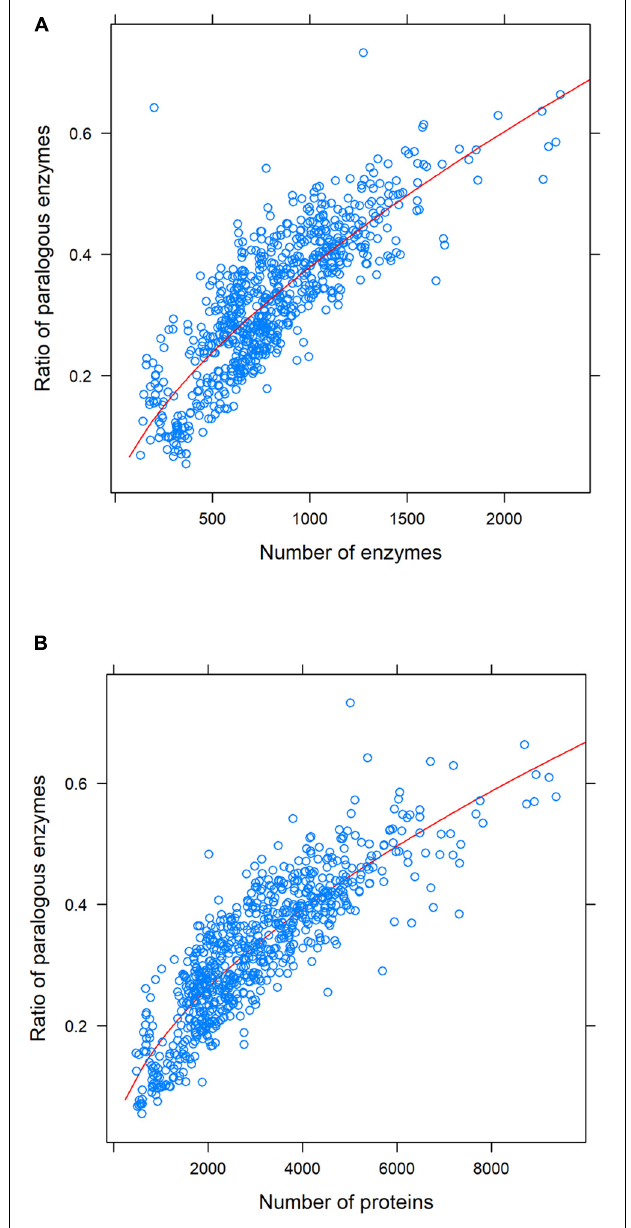
FIGURE 2 | Ratio of paralogous enzymes as a function of the number of enzymes (A) and the number of proteins (B) , for each individual genome. The power-law equation for each adjustment and the R -squared value are as follows: (A) y = 0.003 x 0 . 67 ; R 2 = 0.68; (B) y = 0.003 x 0 . 58 ; R 2 = 0.75. Note that the R -squared value is higher when the number of proteins is considered ( R 2 = 0.75) instead of the number of enzymes ( R 2 =